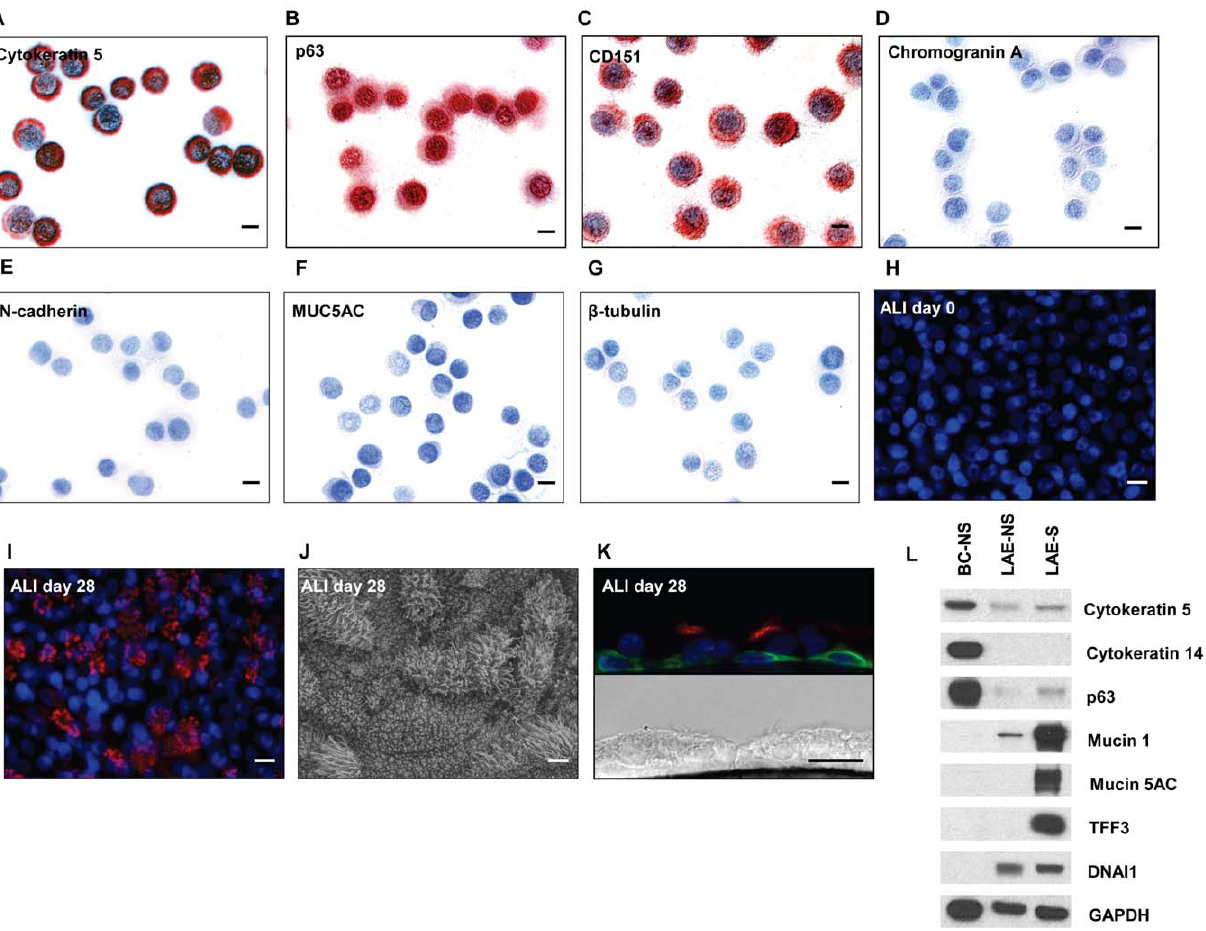
Figure 1. Characterization of cultured human airway epithelial basal cells. Large airway epithelial cells were collected by bronchoscopy brushing of healthy nonsmokers and cultured under basal cell-selective conditions for 7 to 8 days until 70% confluent. A–G. Confirmation of basal cell identity and purity by immunohistochemistry of cytospin preparations using cell type-specific markers. A. cytokeratin 5 (basal cells); B. TP63 (basal cells); C. CD151 (basal cells); D. chromagranin A (neuroendocrine cells) E. N-cadherin (mesenchymal cells); F. mucin (MUC) 5AC (secretory cells) and G. b -tubulin IV (ciliated cells). All cells were counterstained with Mayer’s hematoxylin. H–K. Differentiation of basal cells on air-liquid interface cultures. H. Immunofluorscent staining for b -tubulin IV, day 0 (DAPI, nucleus). I. b -tubulin IV, day 28 (DAPI, nucleus; red, b -tubulin). J. Scanning electron microscopy at day 28. Scale bar for all panels A–J=10 m m. K. Immunofluorescent staining of section of 28 day air liquid interface culture for b -tubulin (red) and cytokeratin 5 (green). L. Western analysis of basal and differentiated cell proteins probing equal amounts of extracts of basal